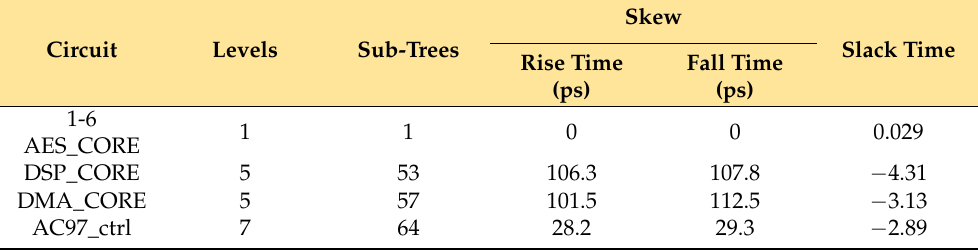
Table 6. Skew results using existing methodology.